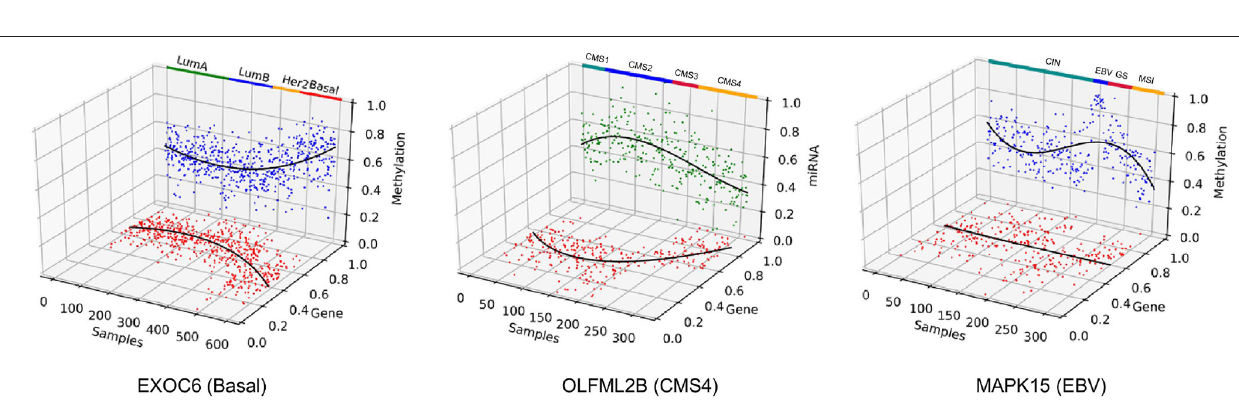
FIGURE 12 | Three genes were selected to show correlation between different types of omics data across patient samples. EXOC6 was associated with the Basal subtype of BRCA, OLFML2B was associated with CMS4 subtype of COAD and MAPK15 was associated with the EBV subtype of